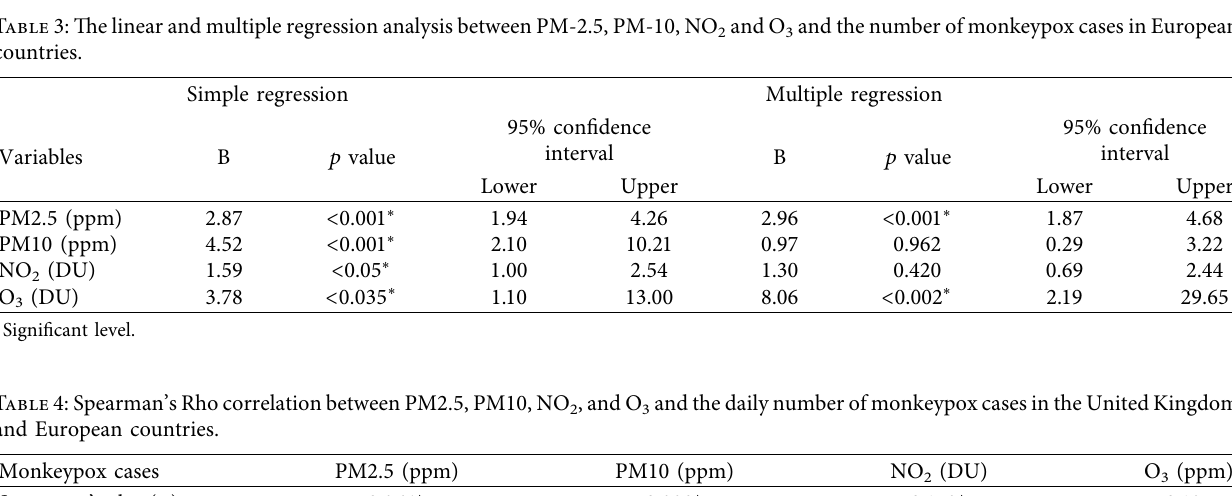
2 and O 3 and the number of monkeypox cases in European